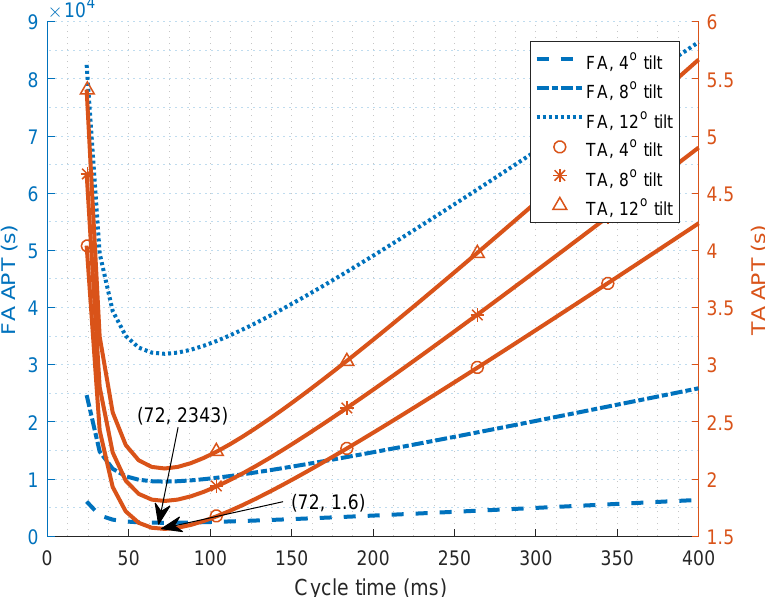
Figure 16. Reduction of the effect of receiver tilt on APT in 12-bit packets through the use of receiver defined threshold angle (TA) instead of the conventional full angle